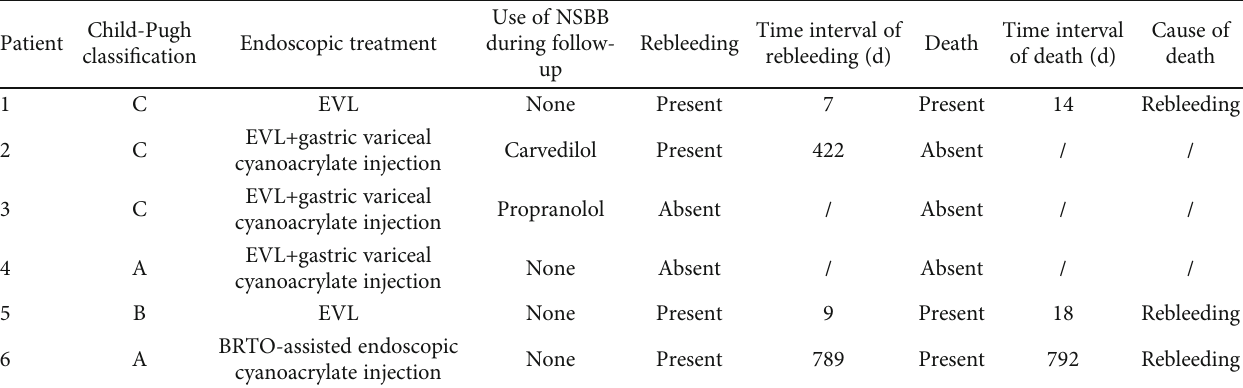
Figure 2: CT and endoscopic ultrasonography(EUS) fi ndings of extraluminal collaterals. (a) Large paraesophageal veins on CT (patient #1). (b) Large paragastric veins on EUS (patient #5). Table 3: Detail of endoscopic treatments and